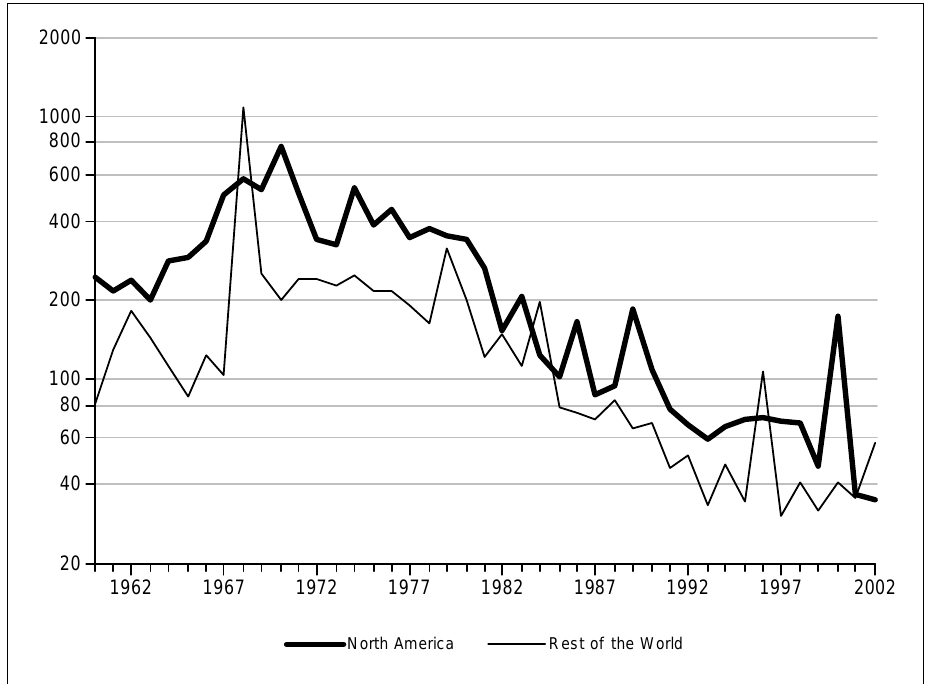
Figure 2. Work Stoppage Rates – North America and the Rest of the World